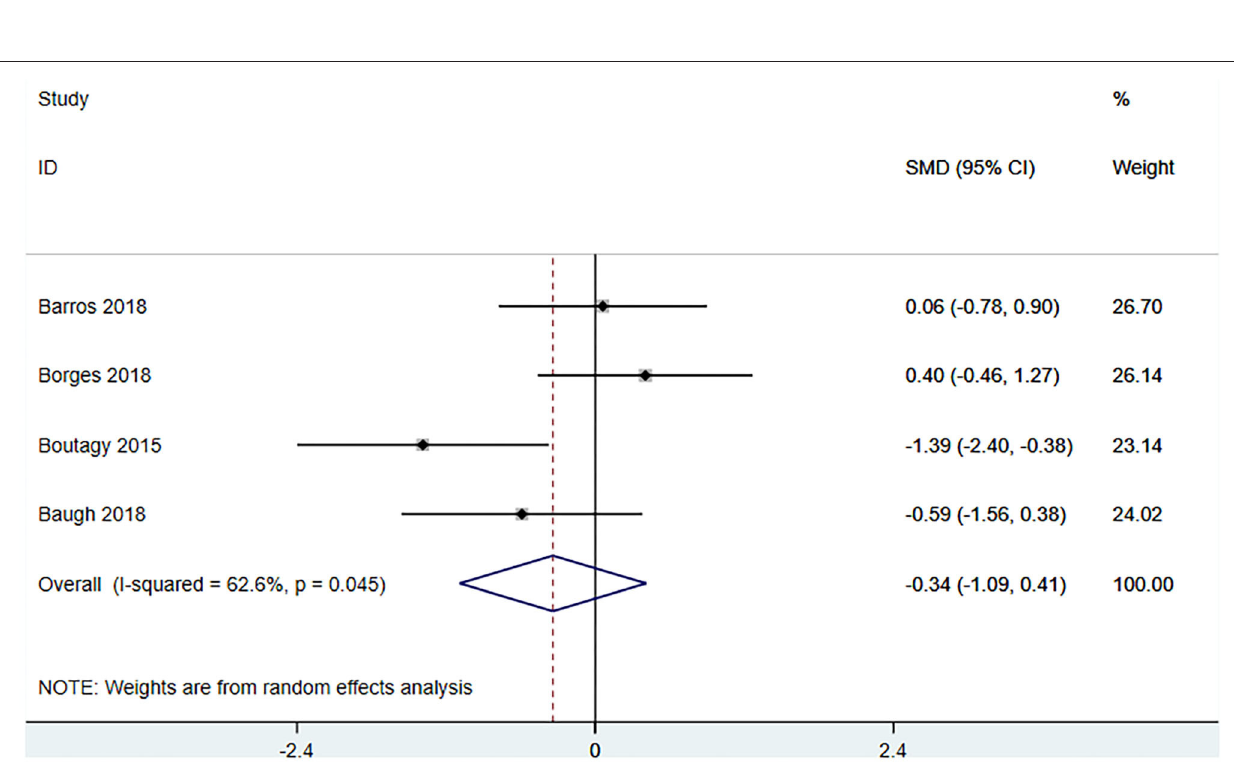
Frontiers in Cardiovascular Medicine | www.frontiersin.org